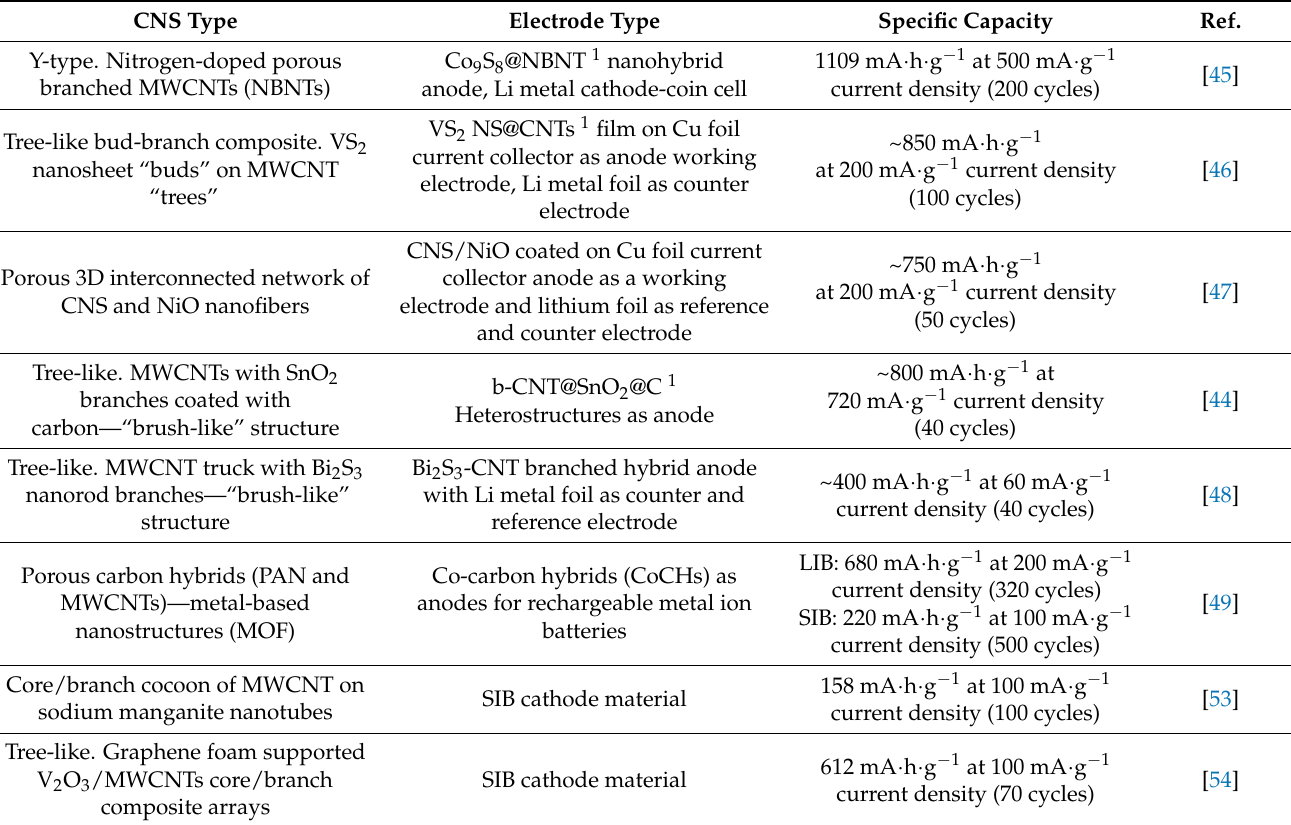
Table 1. Examples of branched CNSs used in battery